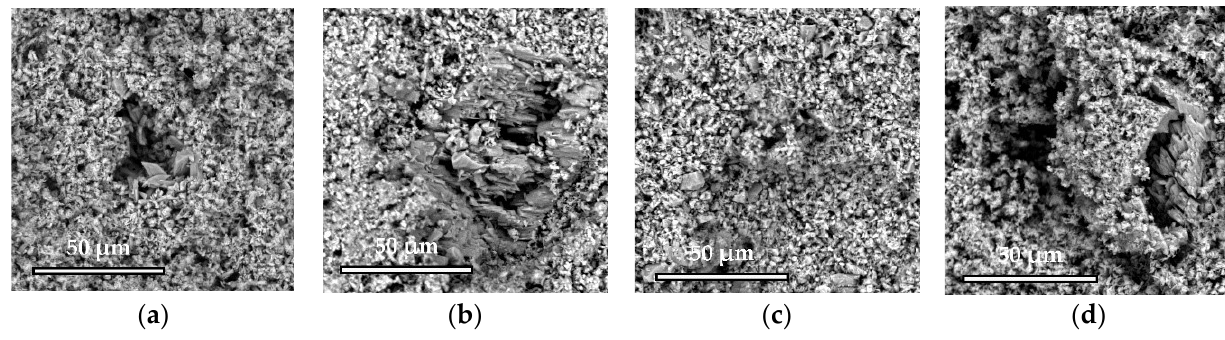
Figure 13. Micrographs of ceramics: N0_SPP_CA_LP0.7 ( a ), N20_SPP_CA_LP0.7 ( b ), N40_SPP_CA_LP0.7